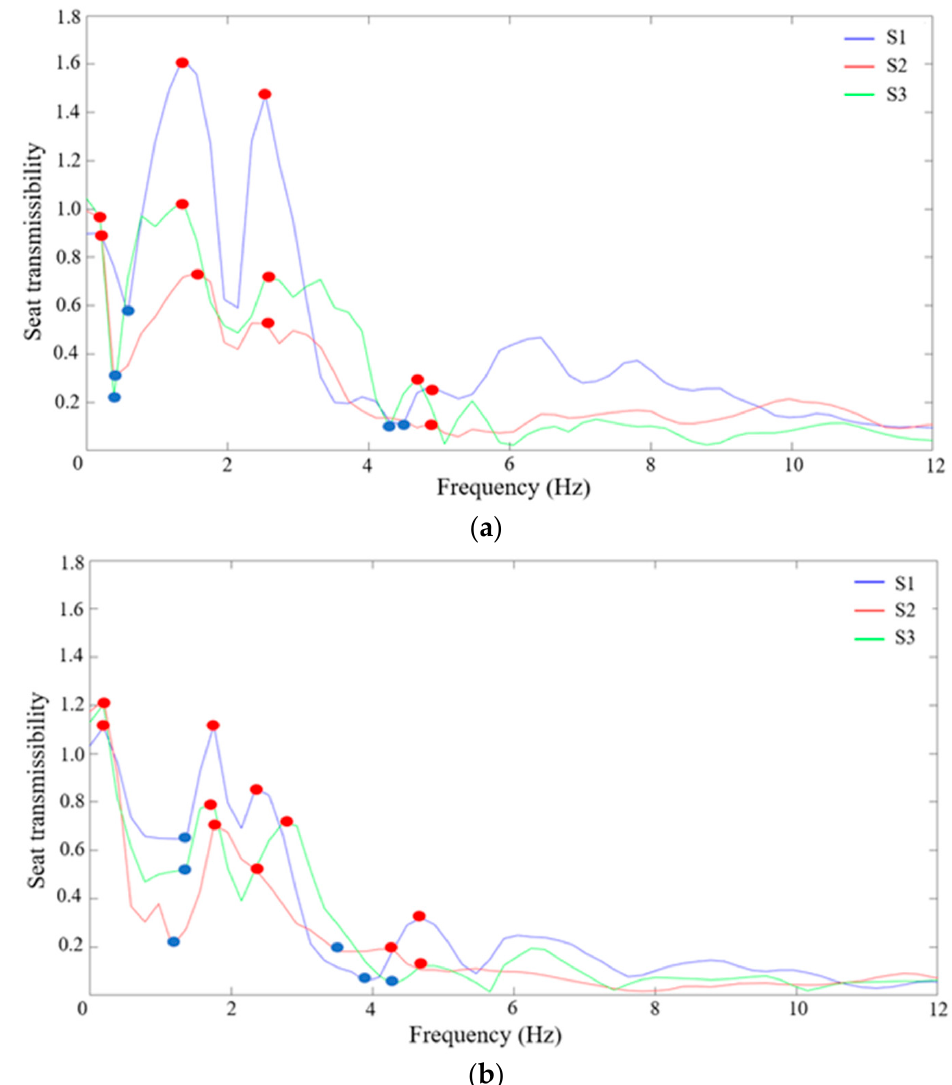
Figure 7. Transmissibility curves: ( a ) comfort seat; ( b ) standard seat.